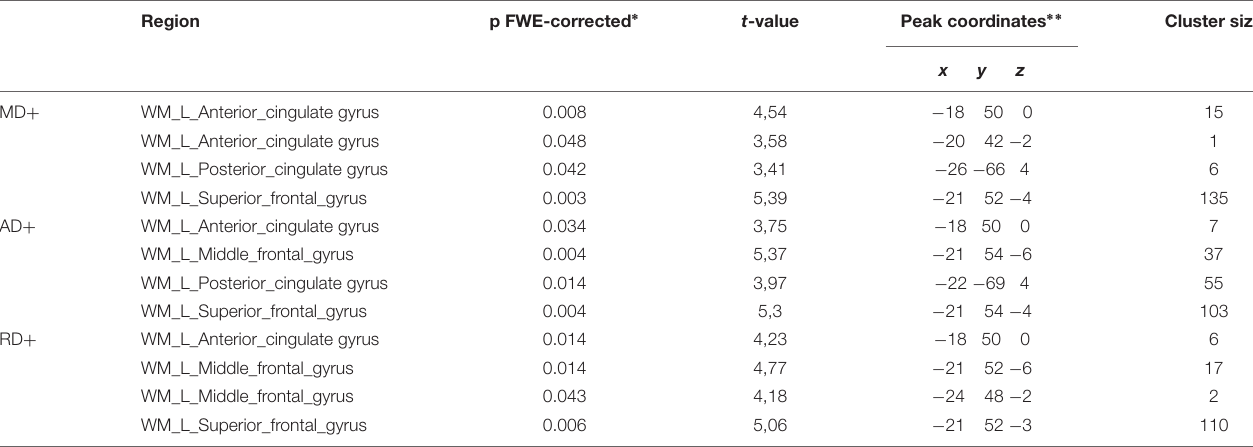
∗ FEW indicates family wise error; ∗∗ peak coordinates represent the location of the maximum pixel values in standard Montreal Neurological Institute (MNI) space. MD + indicates elevated mean diffusivity, AD + elevated axial diffusivity, and RD + elevated radial diffusivity. WM indicates white matter and L, left side of the brain.